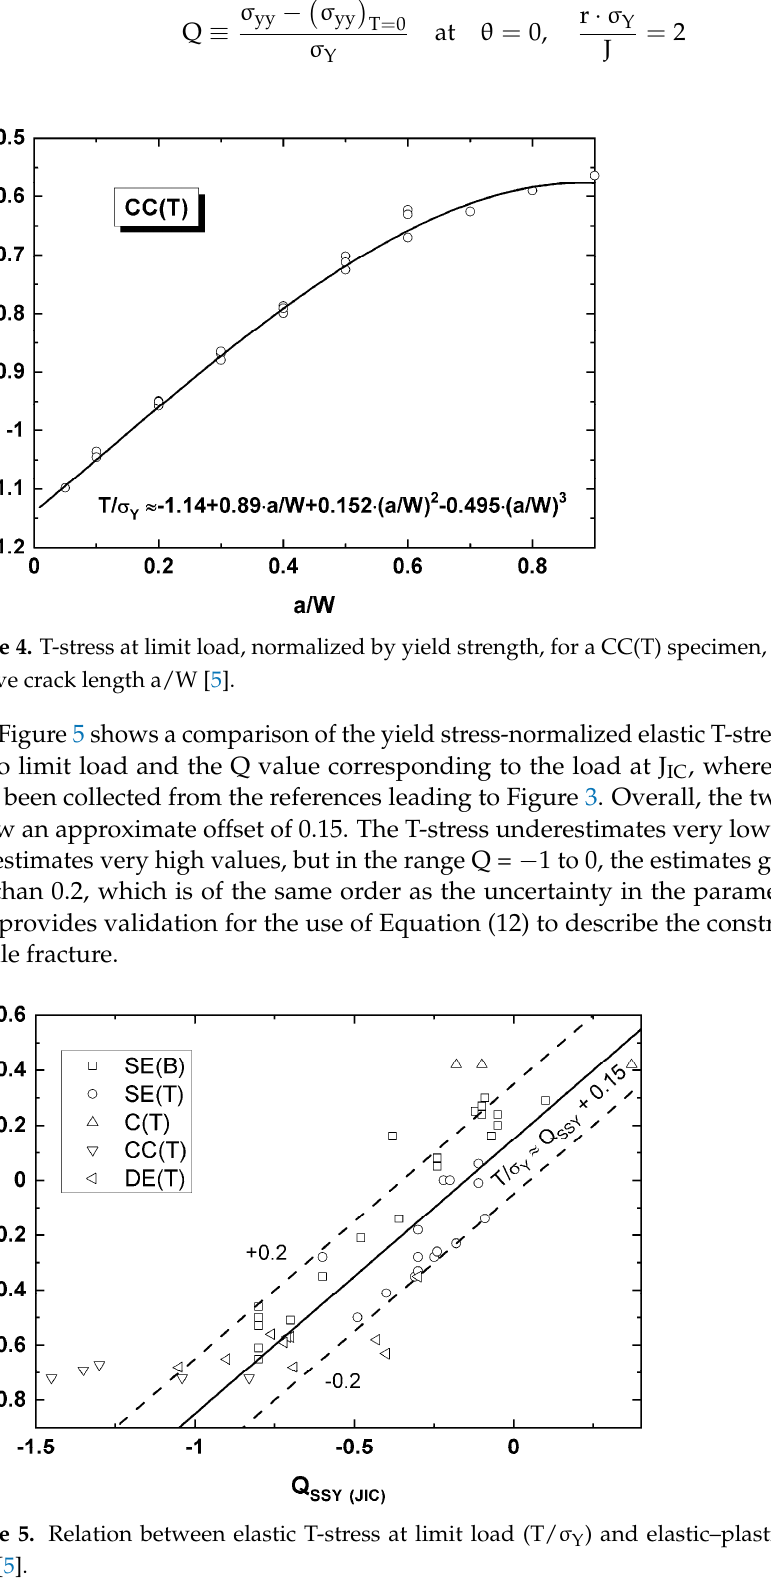
Figure 3. Effect of constraint expressed in the form of T-stress at limit load, on the J-integral for a specific crack growth compared to a high-constraint configuration (J/J T>0 ) [5]. Dashed lines indicate ±15% uncertainty.